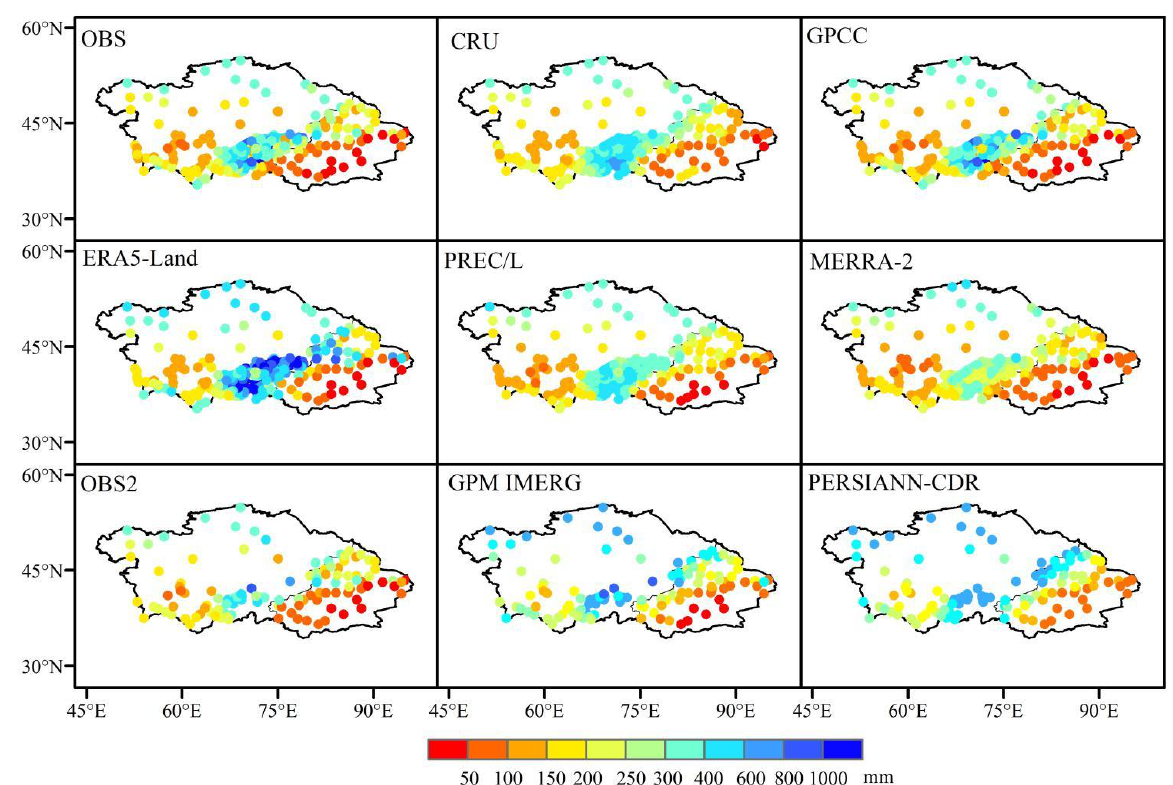
Figure 5. Spatial distribution pattern of average annual precipitation for OBS, OBS2, five OBS-based gridded products, and two OBS2-based gridded products in ACA.